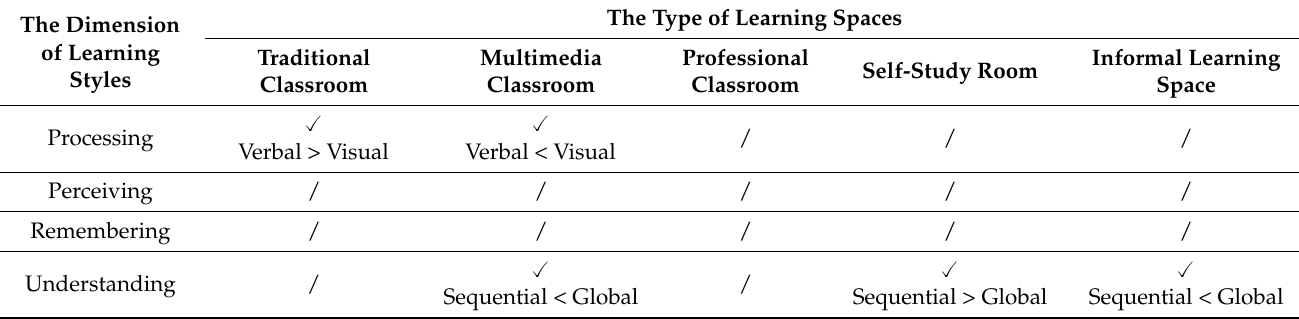
Table 4. The relationship between dimensions of learning styles and perceptions of learning spaces. The Type of Learning